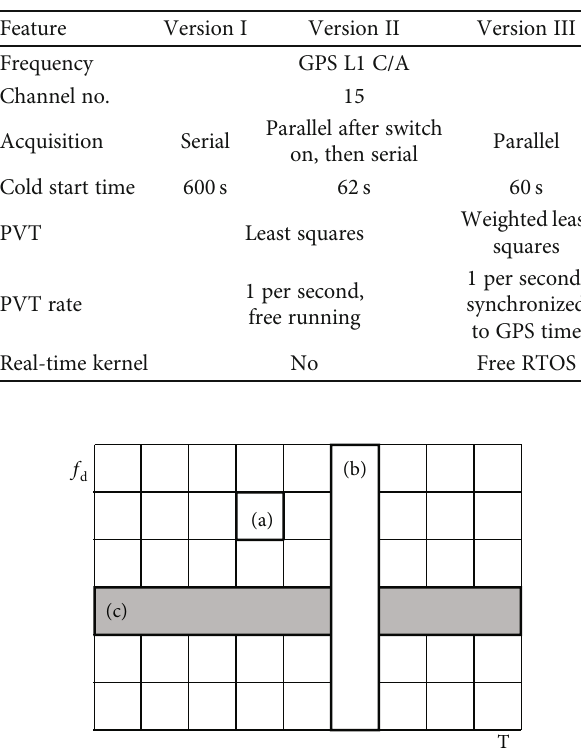
Table 1: piNAV versions.